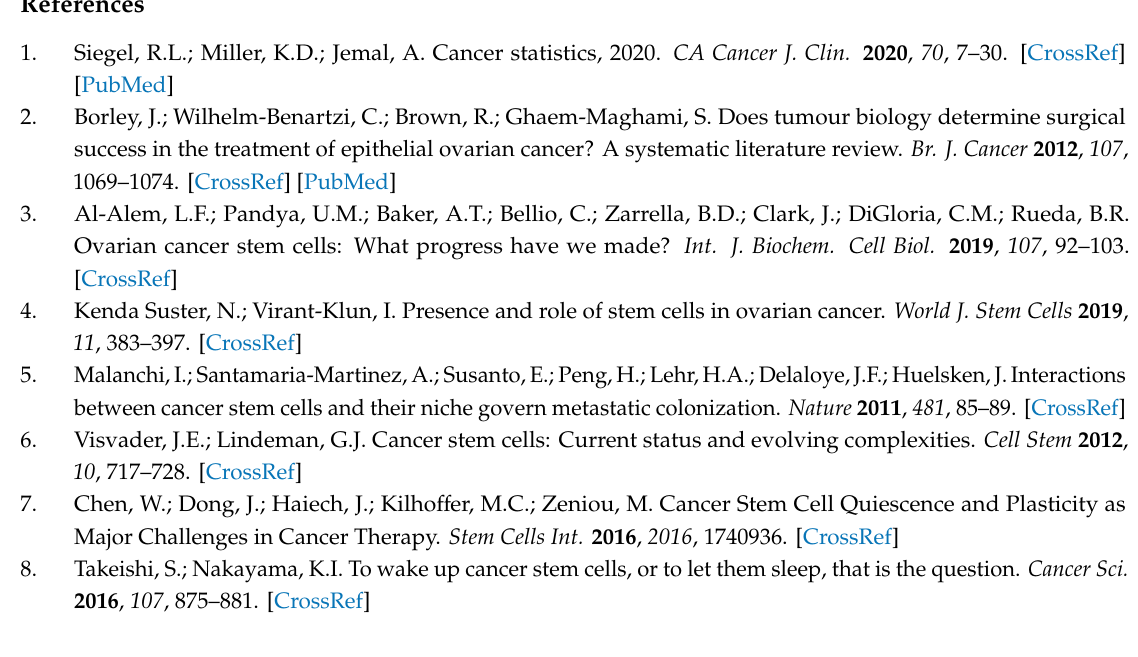
Figure S1: Pearson’s correlation between OvCa stem cell (OCSC) markers. Figure S2: Correlations of OCSC markers with glucose transporters and glycolysis enzymes in OvCa cell lines’ data curated from CCLE. Figure S3: Correlations of OVSC markers with TCA cycle enzymes in OvCa cell lines’ data curated from CCLE. Red indicates positive correlations. Figure S4: Pearson Correlation between the expression of OCSC transcripts and the transcripts of the key enzymes involved in ETC in OvCa cell lines’ data curated from CCLE. Figure S5: Correlations of OCSC markers with fatty acid transporters and lipid metabolism enzymes in OvCa cell lines’ data curated from CCLE. Figure S6: Correlations of OCSC markers with glutamine / glutamine transporters and metabolic enzymes in OvCa cell lines’ data curated from CCLE. Table S1: Pearson Correlation between the expression of CSC transcripts and the transcripts of glucose transporters and the key enzymes involved in glycolysis in OVCAR3 spheroids stem cells curated from GSE28799. Table S2: Pearson Correlation between the expression of CSC transcripts and the transcripts of glucose transporters and the key enzymes involved in glycolysis in undi ff erentiated spheroids stem cells curated from GSE64999. Table S3: Pearson Correlation between the expression of CSC transcripts and the transcripts of the key TCA enzymes in OVCAR3 stem cells from GSE28799. Table S4: Pearson Correlation between the expression of CSC transcripts and the transcripts of the key TCA enzymes in undi ff erentiated OCSCs from GSE64999. Table S5: Pearson Correlation between the expression of CSC transcripts and the transcripts of the key enzymes involved in the Electron Transport Chain in OvCa cell lines curated from GSE28799. Table S6: Pearson Correlation between the expression of CSC transcripts and the transcripts of the key enzymes involved in the Electron Transport Chain in OvCa cell lines curated from GSE64999. Table S7: Pearson Correlation between OCSC markers and lipid transporters and key enzymes in lipid metabolism in GSE28799. Table S8: Pearson Correlation between OCSC markers and lipid transporters and key enzymes in lipid metabolism in GSE64999. Table S9: Pearson Correlation between OCSC markers and glutamate transporters and key enzymes of glutamate / glutamine metabolism in GSE28799. Table S10: Pearson Correlation between OCSC markers and glutamate transporters and key enzymes in glutamate / glutamine metabolism in